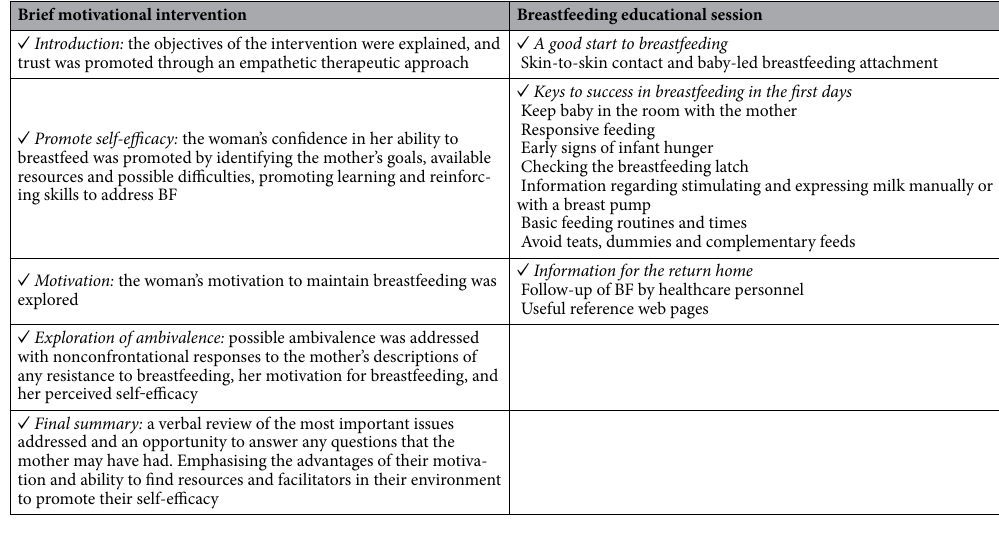
Table 1. Content of the training